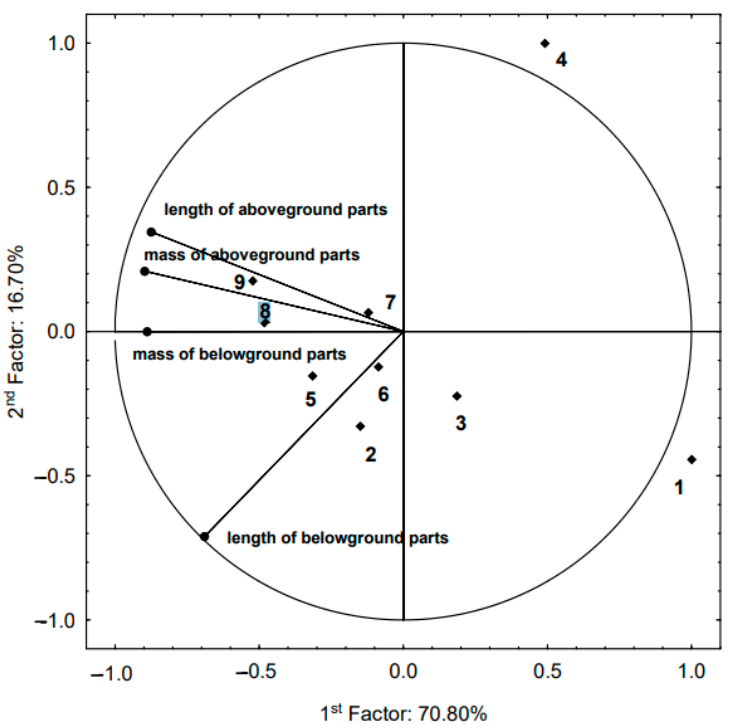
Figure 2. The principal component analysis (PCA) of the basic physiological parameters (the length and weight of belowground and aboveground parts of the plants) for individual variants of the experiment. Explanation: 1. Uninoculated plant (control variant); 2. Plant inoculated with Bradyrhizobium sp. bacteria (isolated from the Nitragina preparation); 3. Plant inoculated with Bradyrhizobium sp. bacteria (isolated from the Nitroflora preparation); 4. Plant inoculated with Bacillus subtilis bacteria; 5. Plant inoculated with Pseudomonas fluorescens bacteria; 6. Plant coinoculated with Bradyrhizobium sp. (isolated from the Nitragina preparation) and Bacillus subtilis bacteria; 7. Plant coinoculated with Bradyrhizobium sp. (isolated from the Nitragina preparation) and Pseudomonas fluorescens bacteria; 8. Plant coinoculated with Bradyrhizobium sp. (isolated from the Nitroflora preparation) and Bacillus subtilis bacteria; 9. Plant coinoculated with Bradyrhizobium sp. (isolated from the Nitroflora preparation) and Pseudomonas fluorescens bacteria.